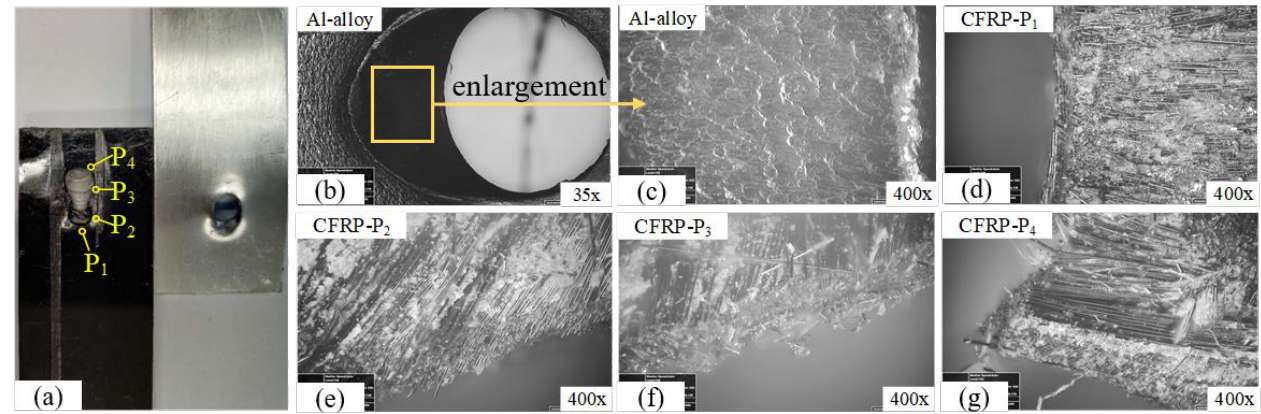
Figure 14. The specimen fracture morphology of the 22° TRM: ( a ) Observation diagram; ( b ) the hole morphology of Al-alloy; ( c ) the enlarged hole morphology of Al-alloy; ( d ) CFRP P 1 area; ( e ) CFRP P 2 area; ( f ) CFRP P 3 area; ( g ) CFRP P 4 area.